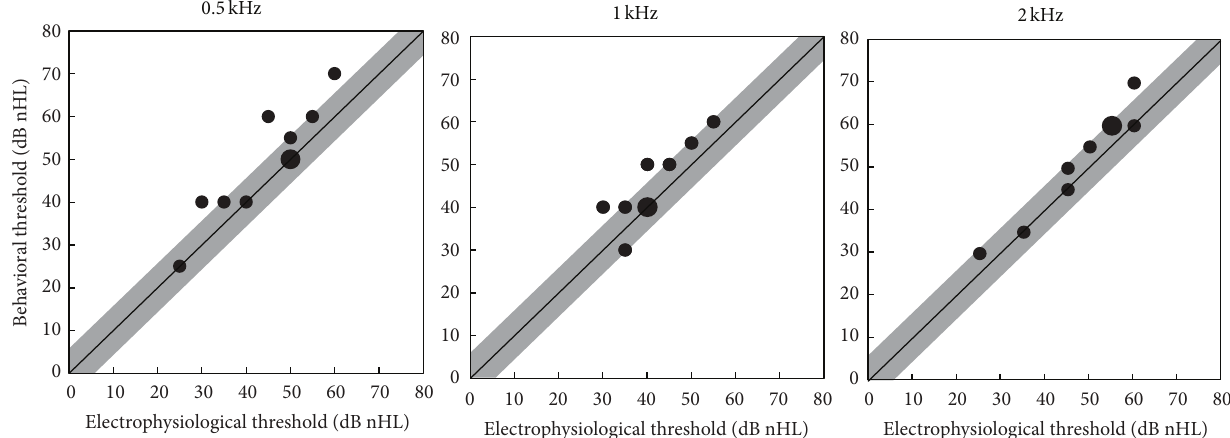
Figure 3: Individual behavioral pure-tone threshold for all subjects as function of the electrophysiologically measured threshold, for both stimulation with the Baha as transducer and frequencies of 0.5 kHz, 1kHz, and 2 kHz shown as bubble chart (small circle: 𝑛 = 1 , large circle: 𝑛 = 2 ). Linear regression analysis was significant for all frequencies. Shaded areas mark the difference of ± 5 dB from the diagonal which was the resolution of the threshold